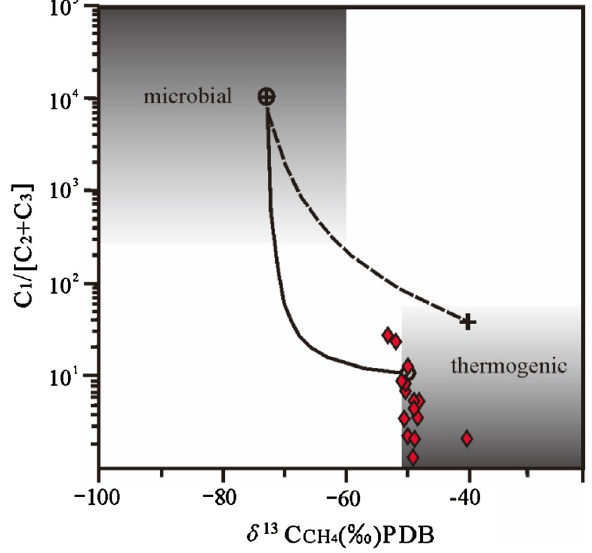
Fig. 7 Volumetric hydrocarbon gas ratio of C 1 /(C 2 ? C 3 ) versus d 13 C of methane to show the methane formation zones. Modelled from Bernard et al. (1978), two suggested mixing lines are indicated between microbial field and thermal sources field; both lines start from the end-member microbial gas ( - 73 % ; 104) and end with thermogenic gas end-member ( - 50 % ; 10) and ( - 40 % ; 50),